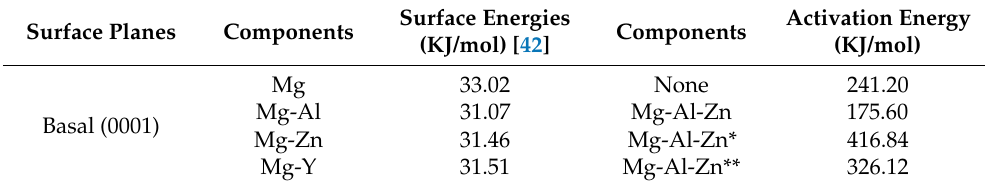
Table 5. Calculated surface energies (kJ/mol) of Mg systems with different surface planes and alloying elements